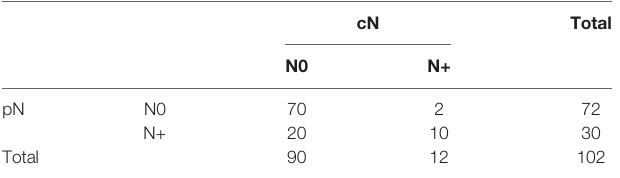
TABLE 1 | Presentation of pathological lymph node groups (pN) with respect to clinical lymph node groups (cN).